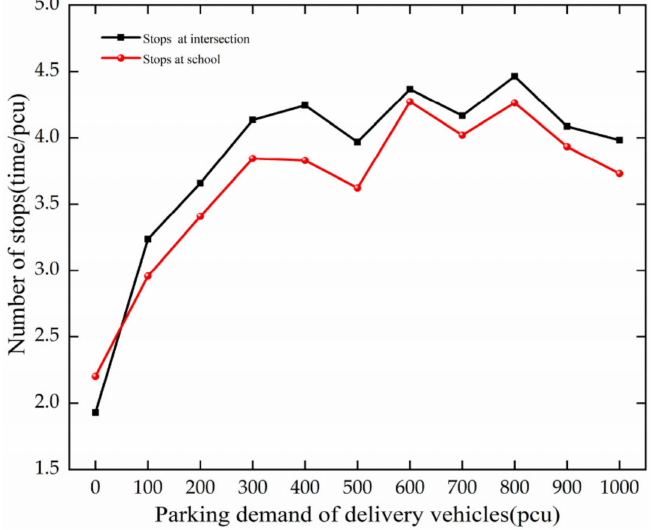
Figure 15. Variation trend of stops with